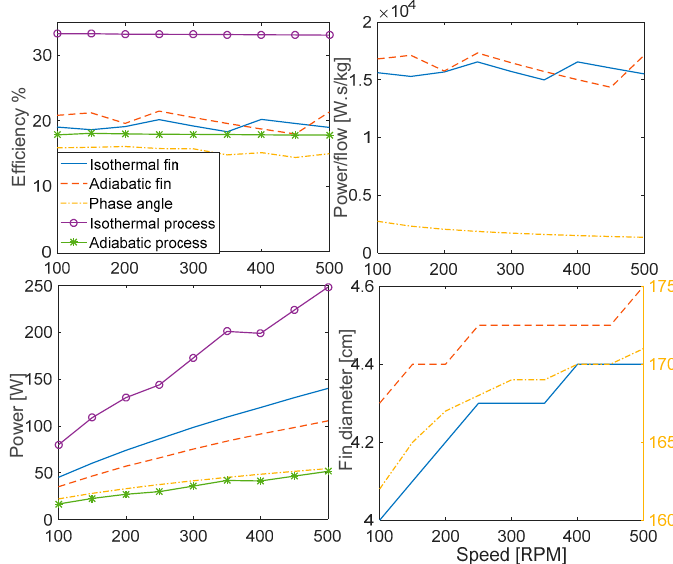
Figure 10. Optimized response based on the maximum power for the Franchot engine using adiabatic and isothermal fins and the bare Franchot engine controlled by the phase angle. The response of the ideal engine with isothermal expansion and with adiabatic expansion is shown for comparison.